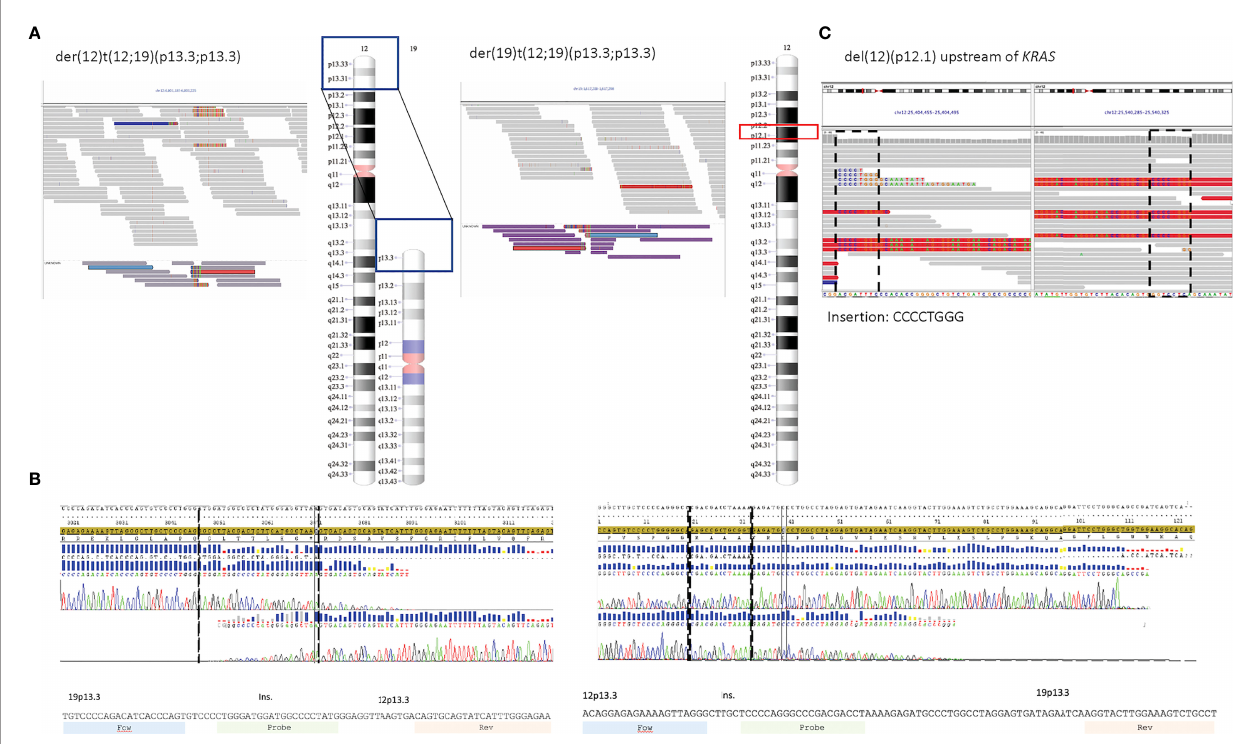
FIGURE 2 | (A – C) Target sequences for patient 1. (A) Screenshots from IGV showing the junction sequences on derivative chromosomes 12 and 19 and ideogram representing the regions involved in the reciprocal translocation. Discordant reads are marked in medium gray ( ZNF384 locus) and purple ( TCF3 locus). (B) Sanger sequencing con fi rmed the sequence to be identical to the sequence derived from WGS data, including the non-templated insertion in both junctions (sequences within broken lines). (C) Screenshots from IGV (discordant reads in red) and ideogram representing the deletion on 12p12.1 (upstream of KRAS ). IGV, Integrated Genome Viewer; WGS, whole-genome